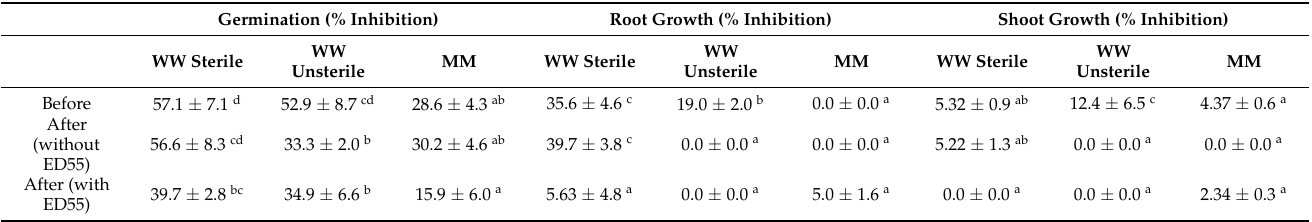
Table 3. Acute toxicity tests performed with Lactuca sativa